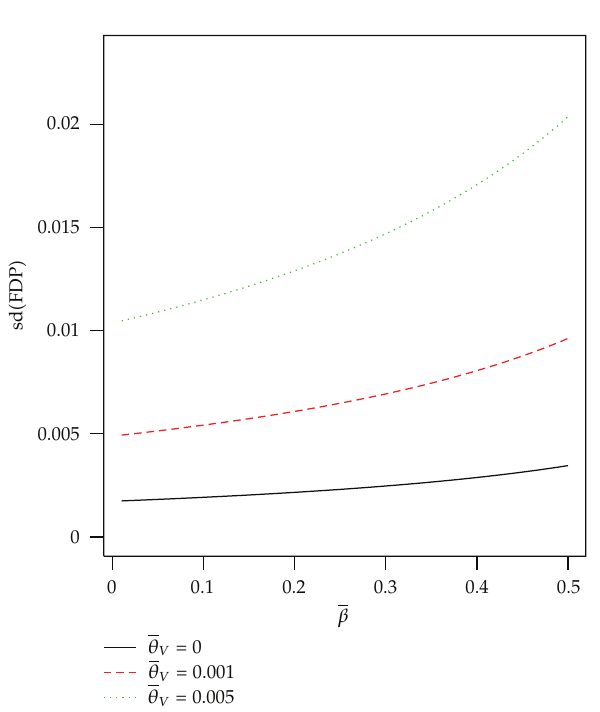
Figure 3: Plots of sd (cid:2) FDP (cid:3) at di ff erent β and θ V . m (cid:8) 10000, π 0 (cid:8) 0.7, α (cid:8) 0 . 004, θ U (cid:8) 0.001 and θ UV (cid:8) 0.